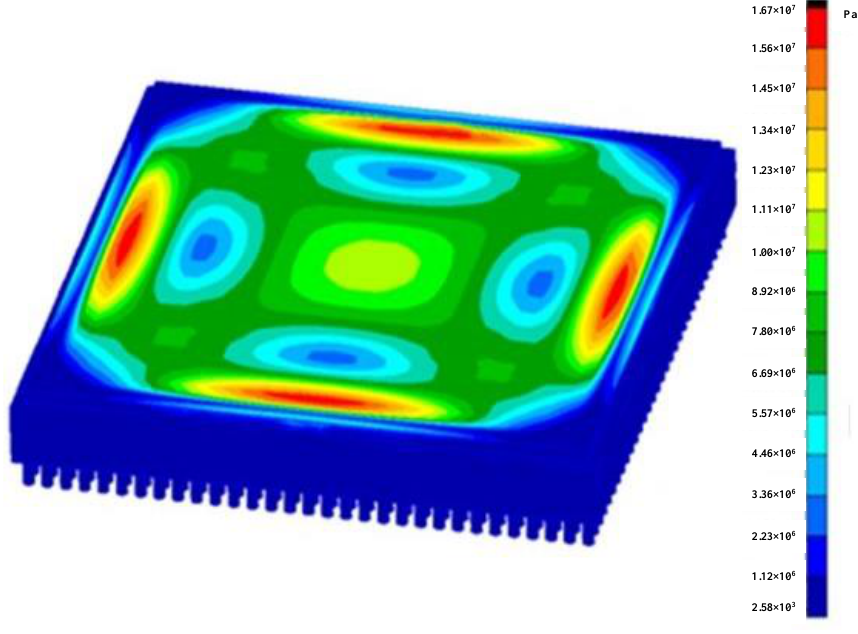
Figure 4. Distribution of the chip under 200 g acceleration.